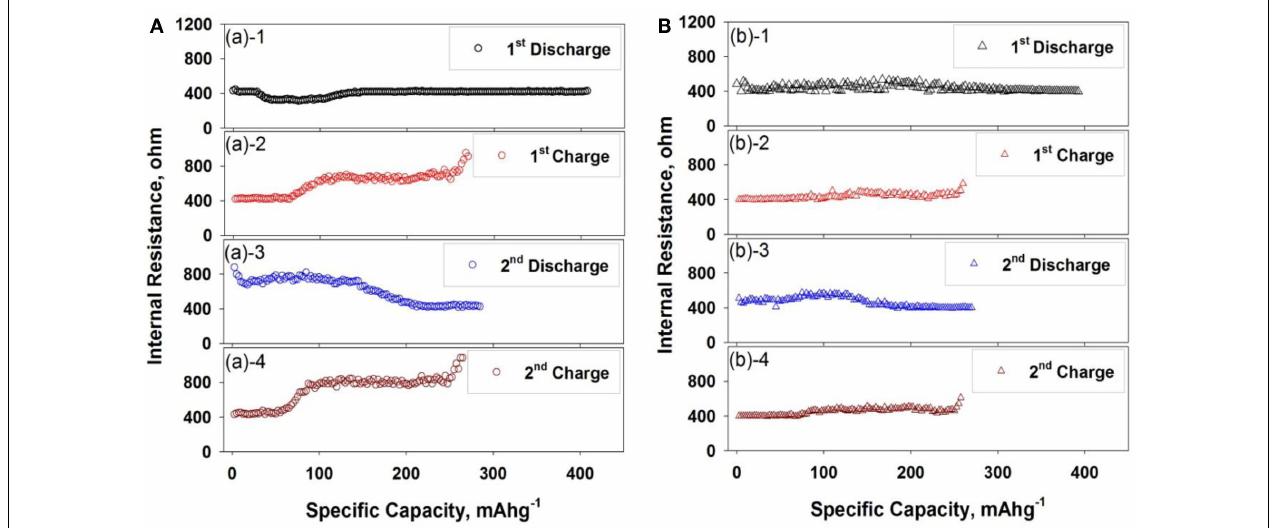
FIGURE 8 | Internal resistance change of LTO- and Al 2 O 3 -coated LTO at first two charge–discharge cycles: (A) LTO electrode and (B) Al 2 O 3 -coated LTO electrode .